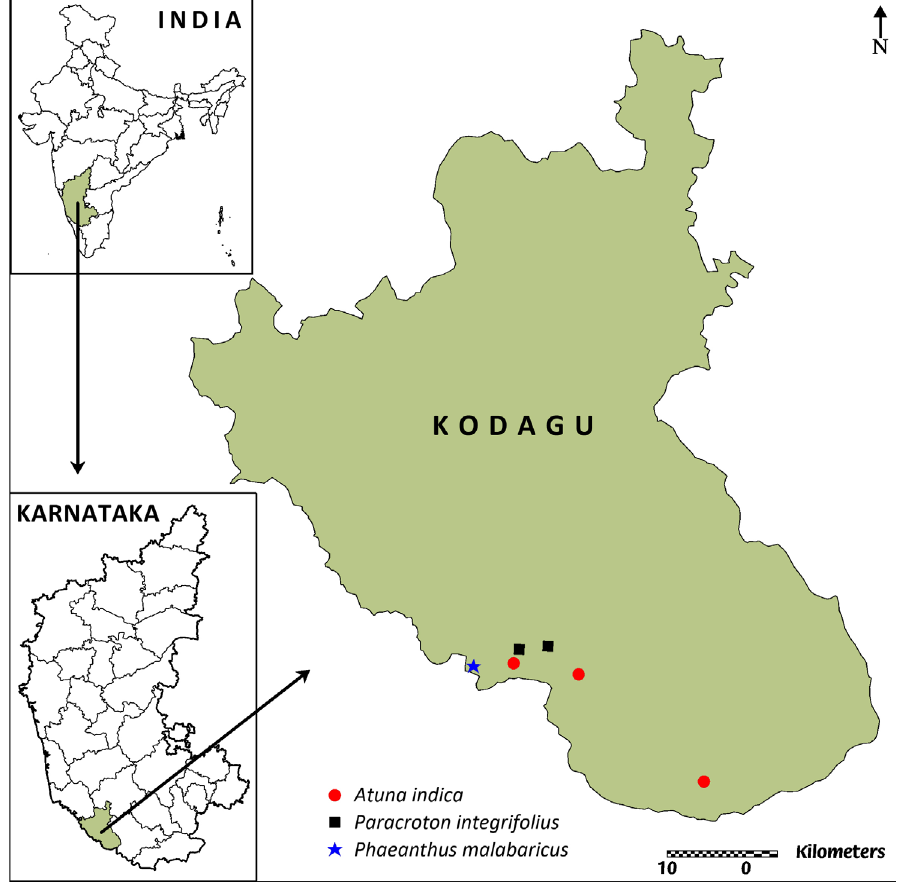
Figure 1. Map of Kodagu District, Karnataka showing specimen collection